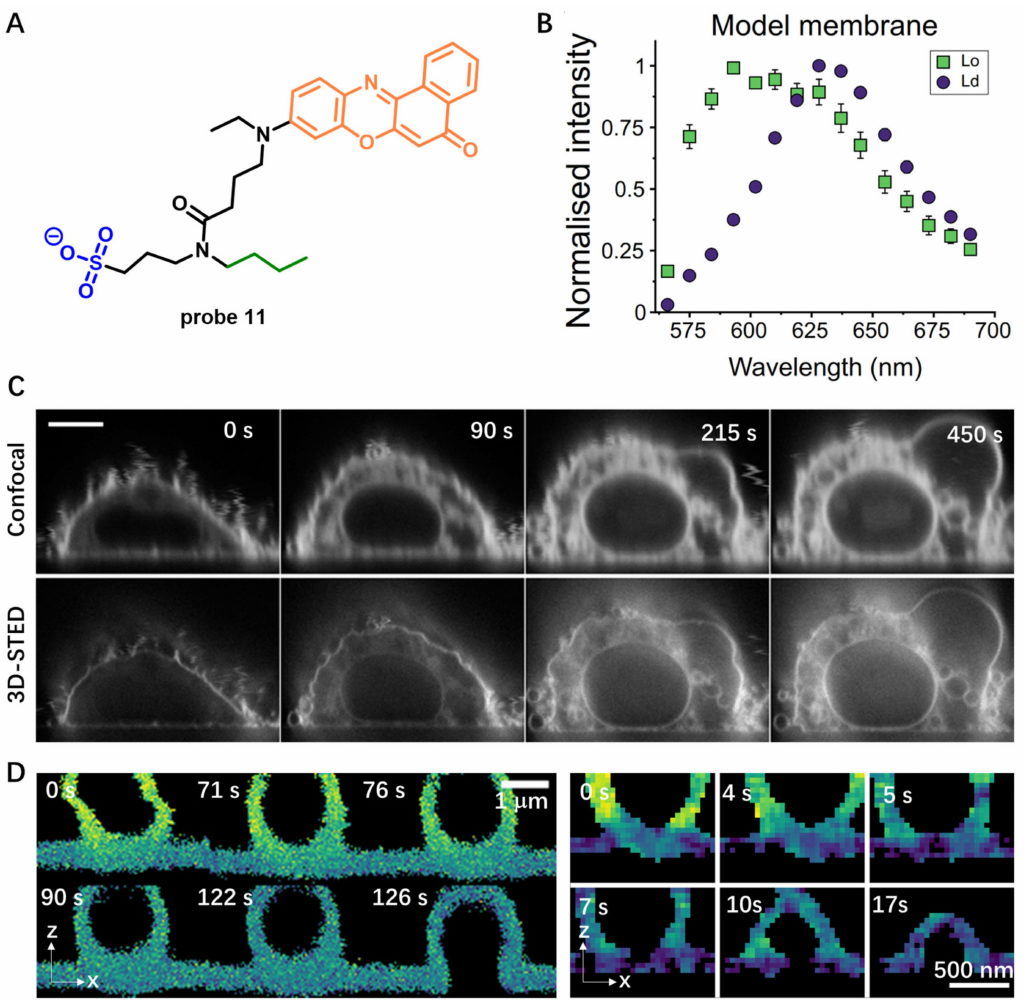
Figure 11. ( A ) Chemical structure of probe 11 . ( B ) The emission spectrum of probe 11 shifts in response to lipid packing. Insert: Lo means liquid-ordered lipid packing, and Ld means liquid- disordered lipid packing. ( C ) Confocal and 3D-STED of CHO cells (up) (Scale bar: 10 µ m) or ( D ) model membranes (down) using probe 11 . Copyright 2021 Biophysical Society